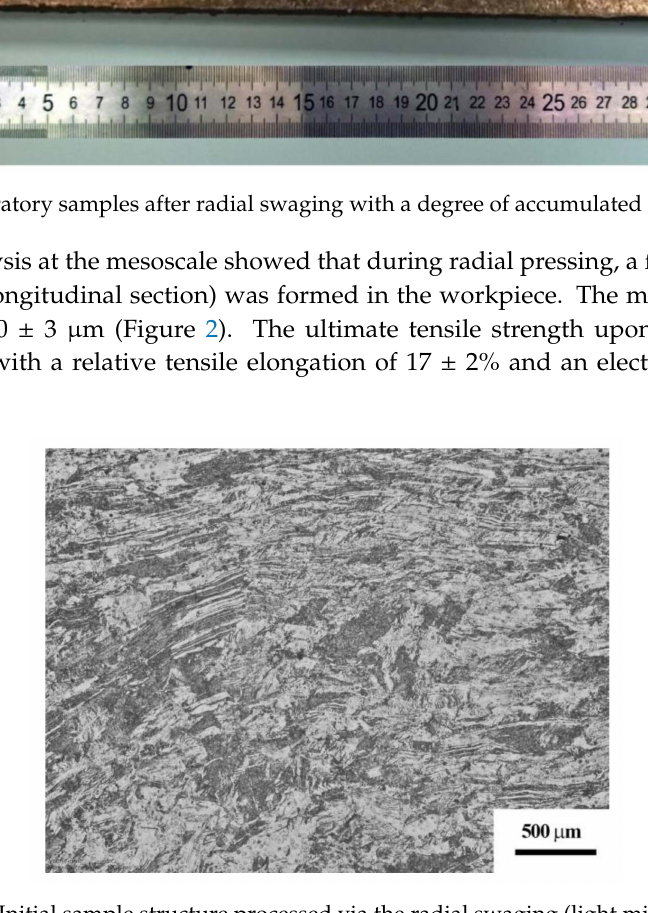
Figure 2. Initial sample structure processed via the radial swaging (light